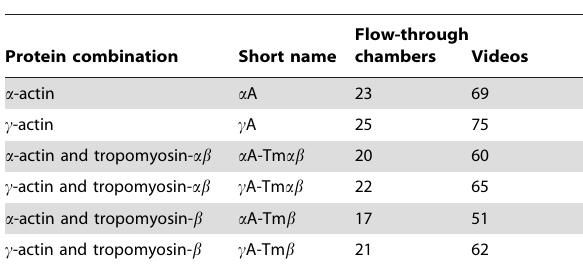
Table 1. Experimental